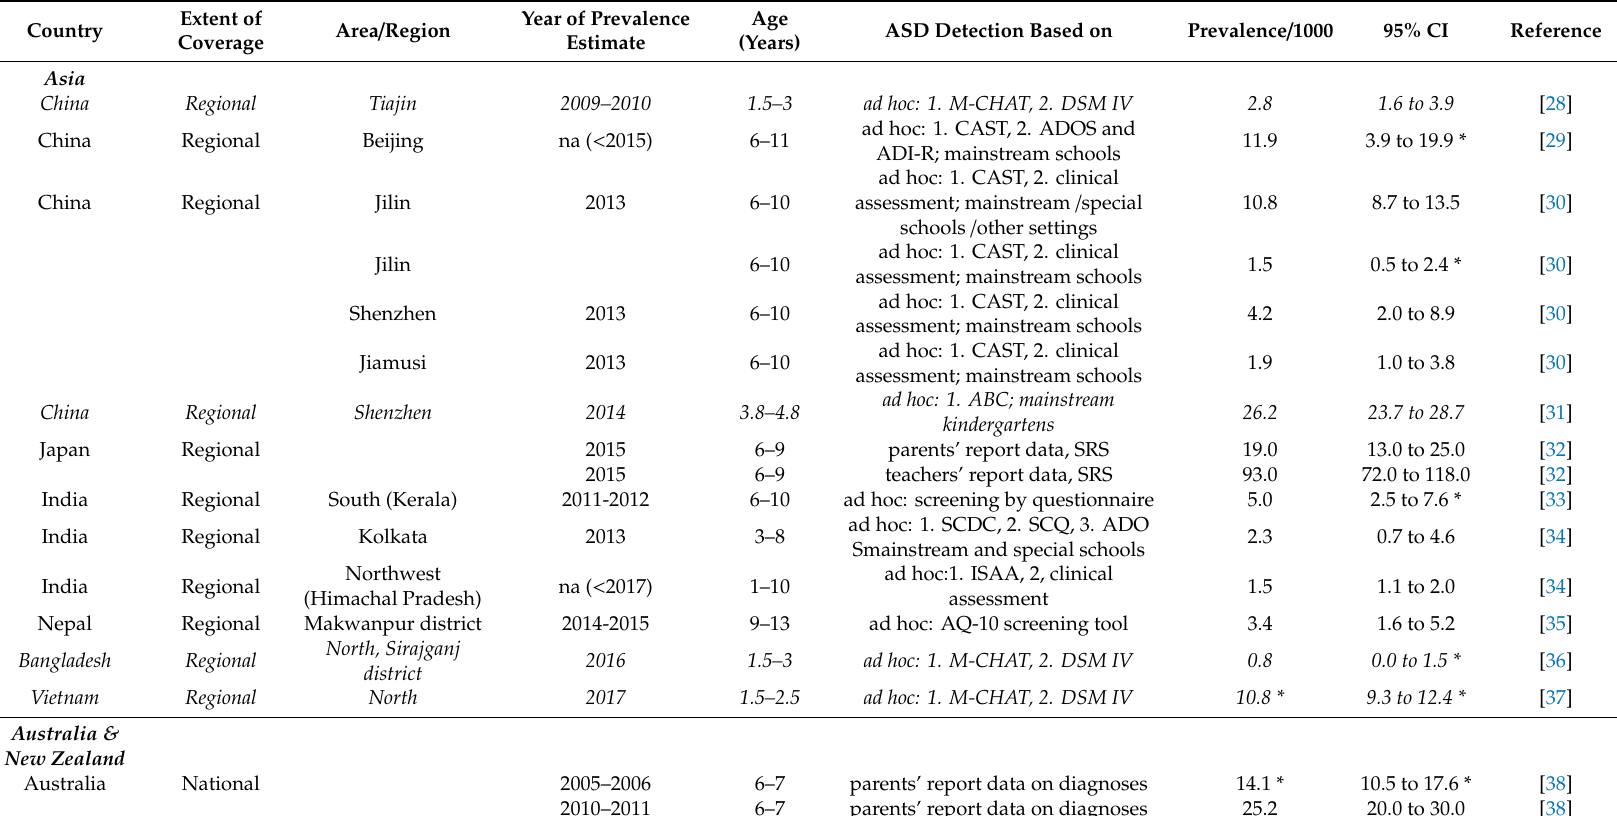
Table 3. Summary of prevalence studies published since 2014 in Asia, Australia &New